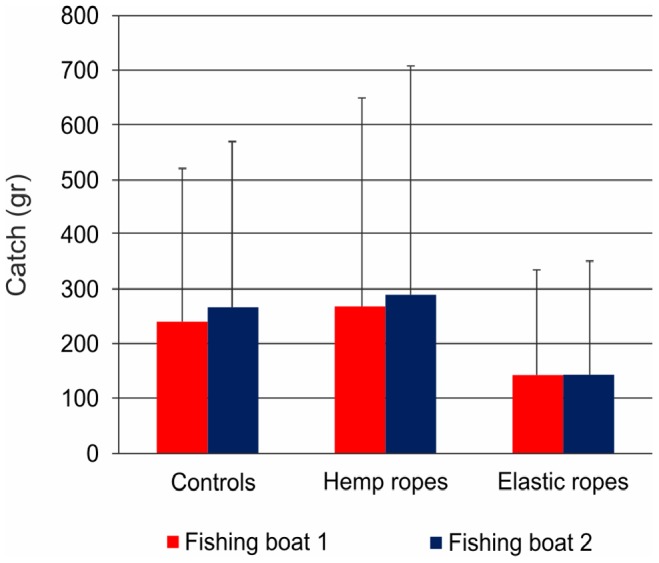
Cuttlefish catches.Average cuttlefish catches (by weight) in traps with hemp ropes, elastic ropes and controls for the two fishing boats. Bars represent standard deviations. The colours are the same as in Figure 1.